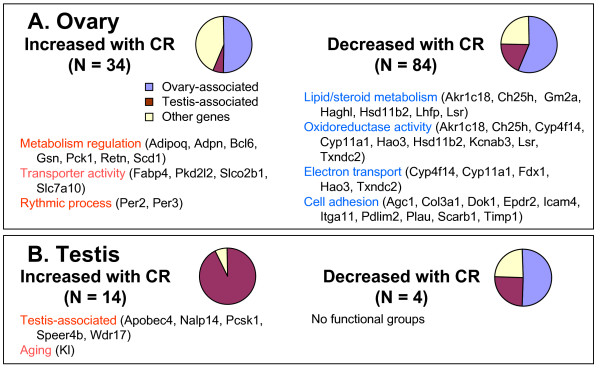
Functional groups of genes affected by diet (AL versus CR). (A) Ovary and (B) testis. Pie charts show the proportion of genes that were over-expressed either in ovary or testis by at least two-fold. Functional categories of genes were assembled from GO annotations and from PubMed.